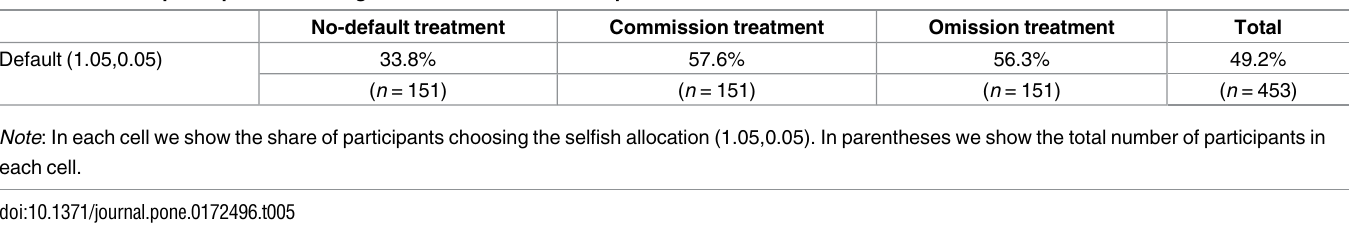
Table 5. Share of participants choosing the selfish allocation in Experiment 2.